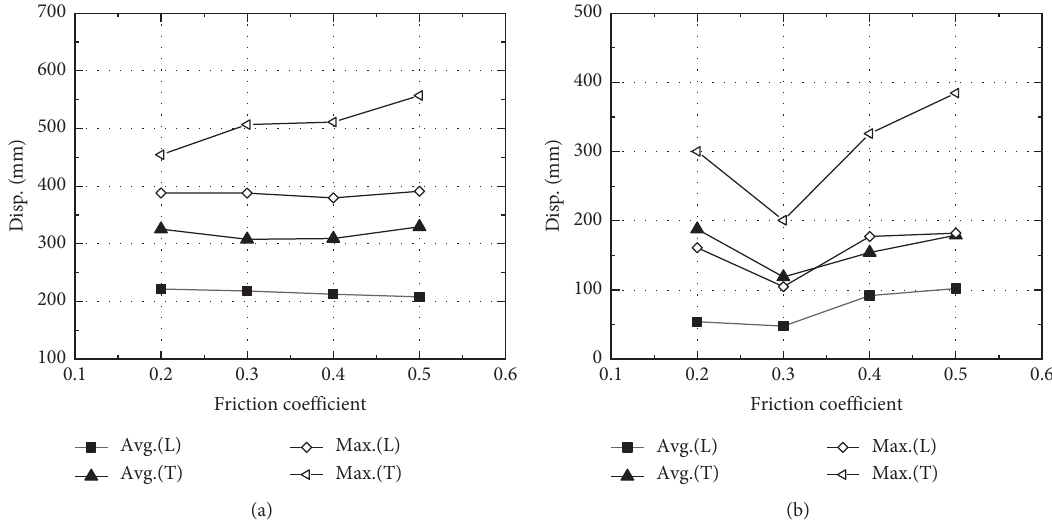
Figure 18: Effect of C R on the bearing displacements. (a) Maximum displacement. (b) Residual displacement.